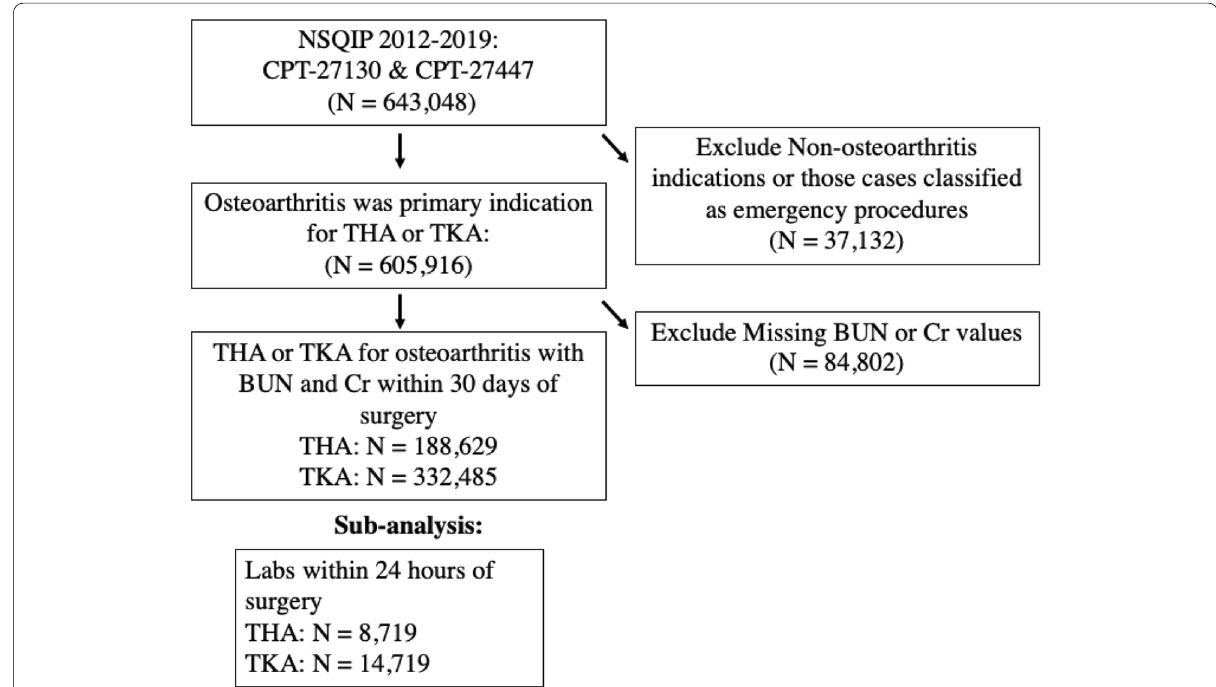
Fig. 1 Flow diagram representing arrival at overall patient population as well as the population used for supplemental sub-analysis of those patients with BUN and creatinine labs drawn within 24 h of